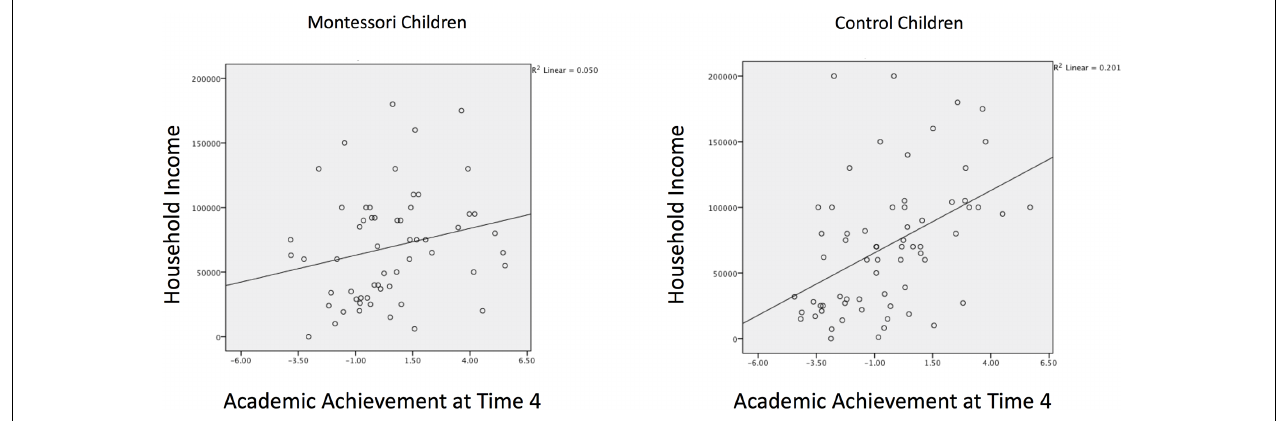
FIGURE 4 | Relation between academic achievement and household income in Montessori and control children at the end of the kindergarten year. The relation is significantly smaller in Montessori children ( n = 58, left panel ) than in control children ( n = 66, right panel